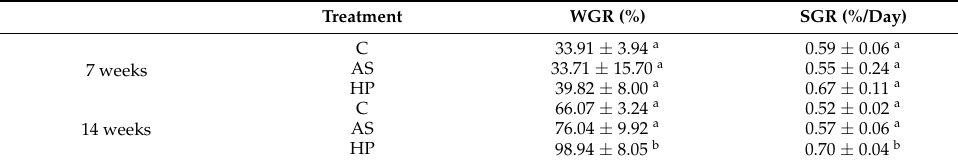
Table 2. The growth performance of P. leopardus during the 14-week feeding experiment.